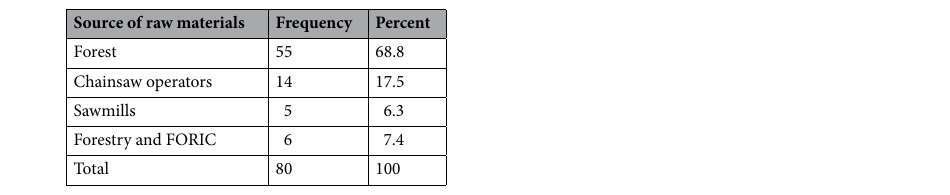
Table 6. Sources of Raw Materials for SMFEs.